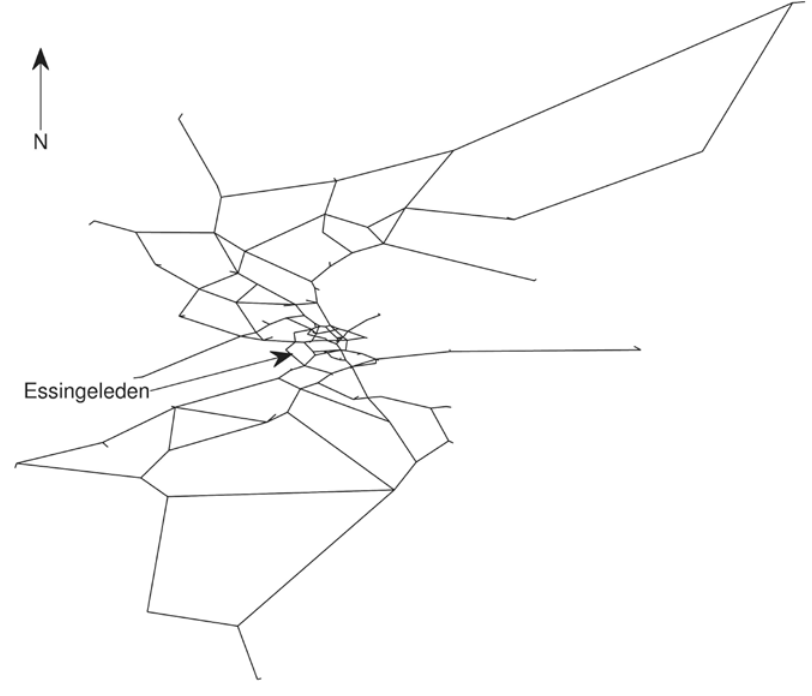
Figure 2. The Stockholm